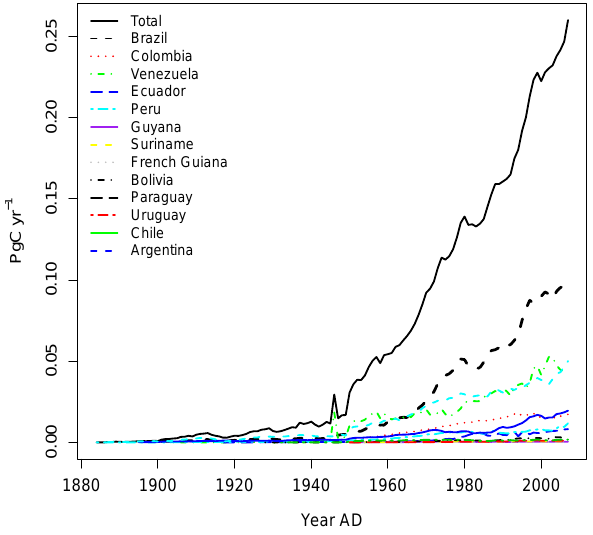
Fig. 6. Fossil fuel emissions estimated based on national energy statistics (Marland et al.,